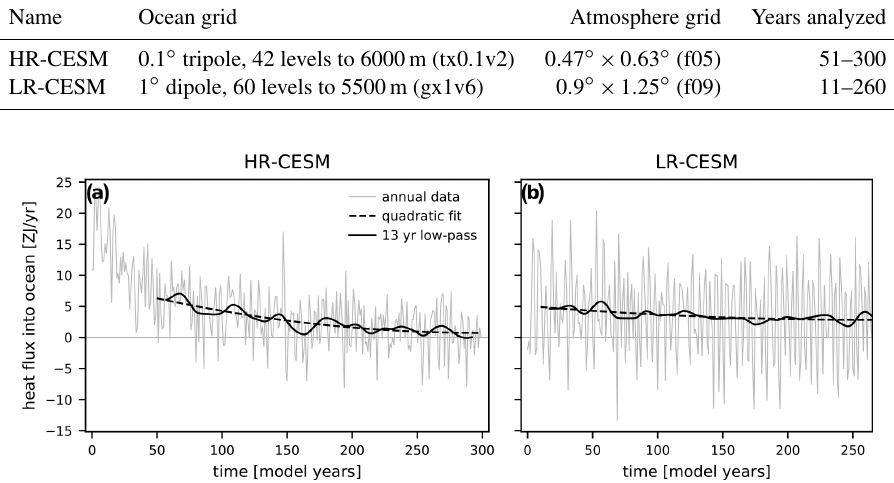
Table 1. Overview of the two CESM simulations with characteristics and names of their ocean and atmosphere grids.